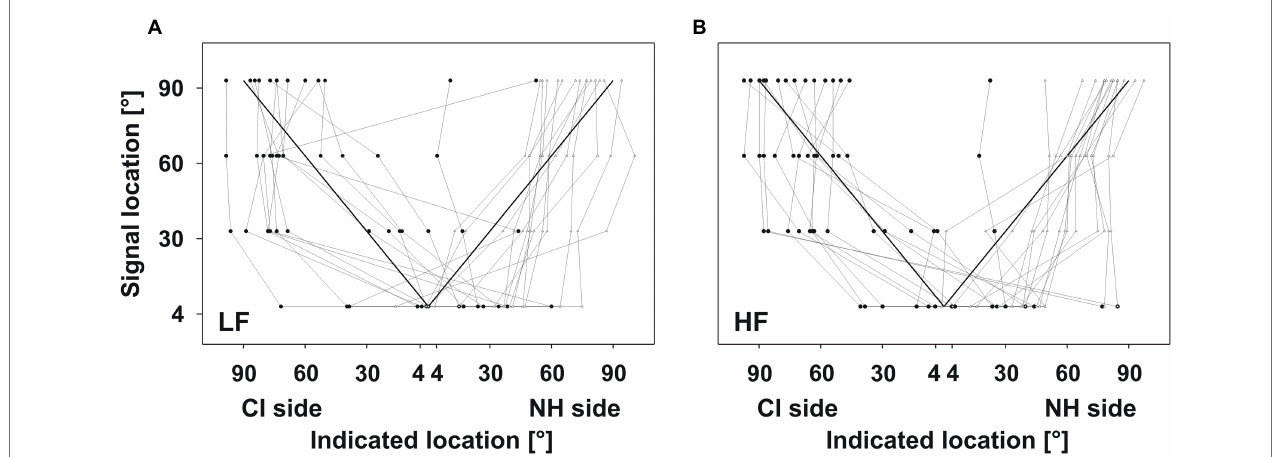
FIGURE 3 | Good performers. Indicated locations plotted against the signal location. Layout of the plots as in Figure 2 . Symbols show the median of five signal presentations for every participant, separately. Black circles indicate signals presented on the CI side, whereas gray triangles indicate signals presented on the NH side. Participants were able to identify signals on the CI and on the NH side. Some of them showed a trend for correct localization from frontal to lateral signal locations.